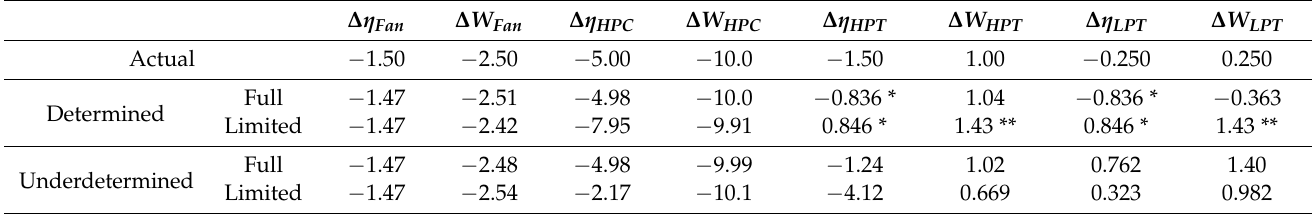
Table 9. Actual and estimated degradation patterns, without measurement noise. * Efficiency equal hurt assumed. ** Flow capacity equal hurt